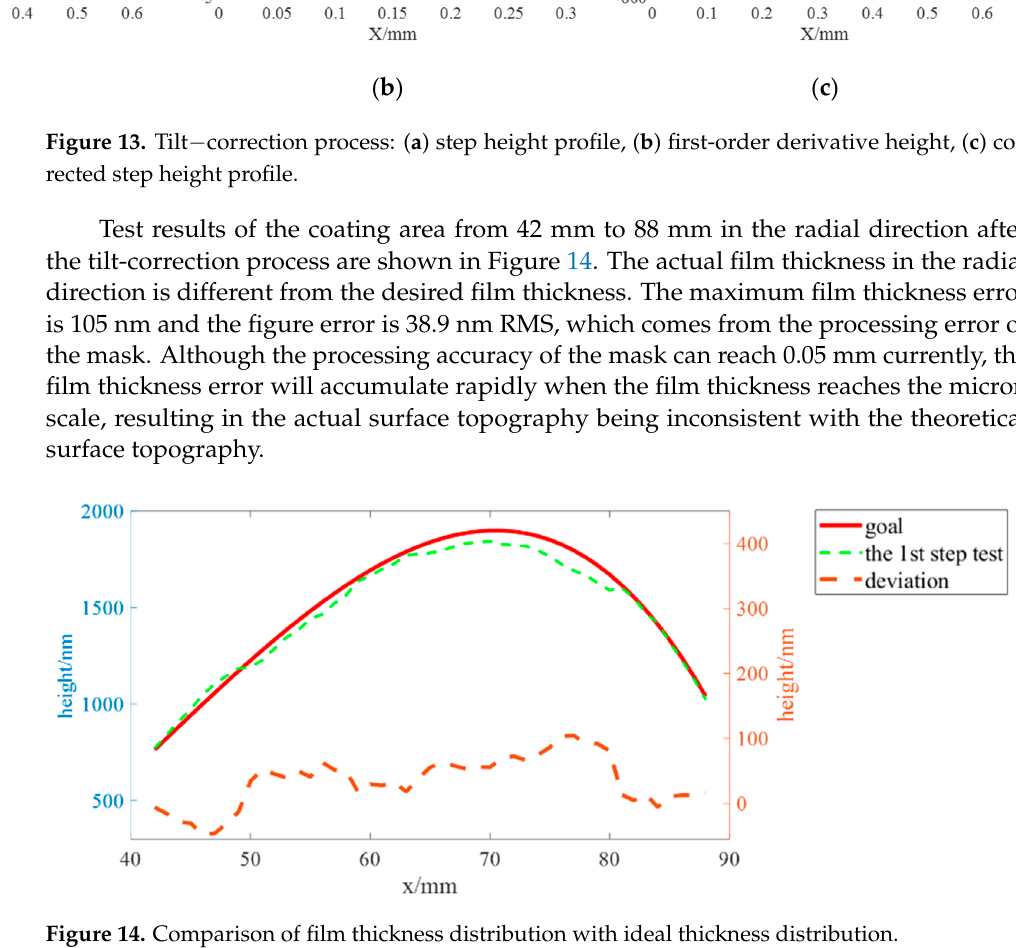
Figure 13. Tilt − correction process: ( a ) step height profile, ( b ) first-order derivative height, ( c ) cor- rected step height profile.